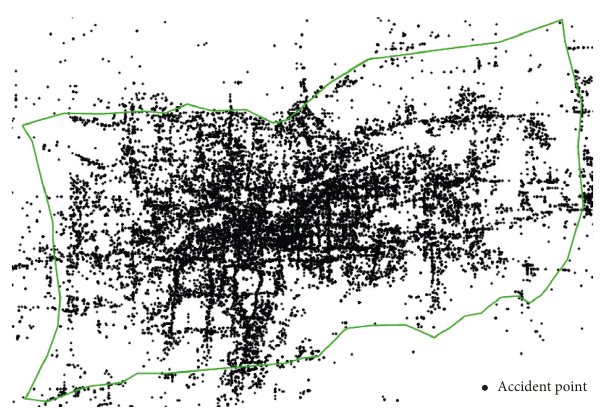
Figure 8: POI of the study area.